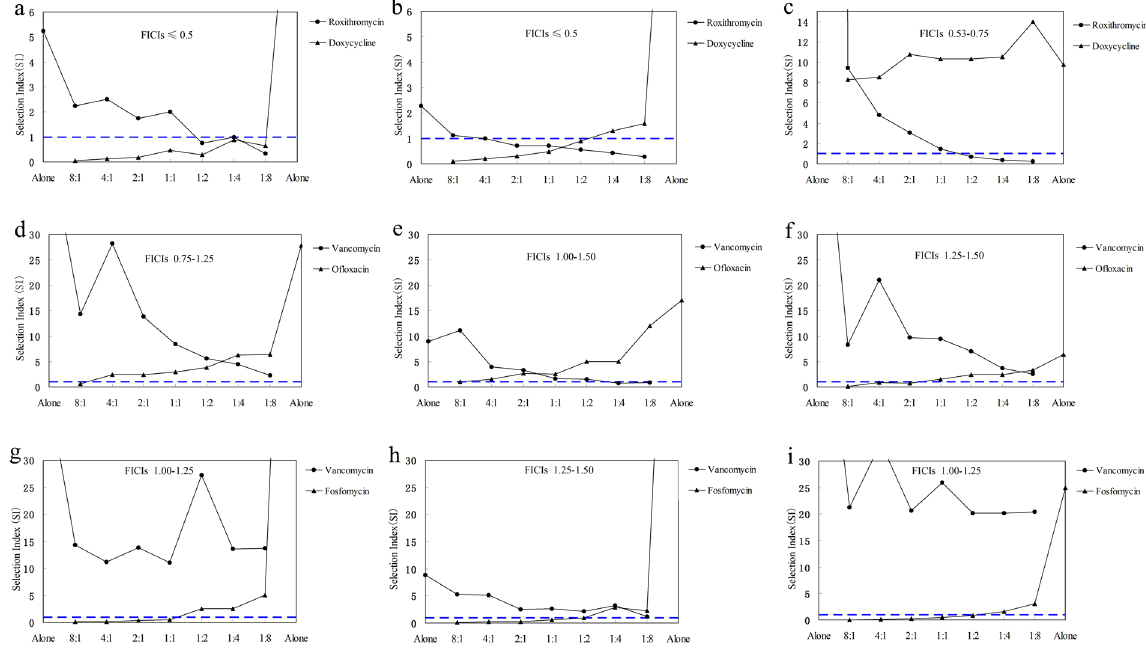
Figure 1. Mutant selection indexes (SIs) of antimicrobial agents in three combinations with different fractional inhibitory concentration indexes (FICIs) against three clinic MRSA isolates. ( a – c ), combination roxithromycin/ doxycycline against clinical isolates MRSA 01, 02 and 03; ( d – f ), combination vancomycin/ofloxacin against clinical isolates MRSA 01, 02 and 03; ( g – i ), combination vancomycin/fosfomycin against clinical isolates MRSA 01, 02 and 03. That the FICIs of combinations were less than or equal to 0.50 meant that two agents in combinations presented synergistic activities against a specific MRSA isolate. That the SIs of two agents in a combination including seven proportions were simultaneously less than or equal to one represented their MSWs were closed each other. ( a – f ) were published as an abstract of poster presentation at ISAAR&ICIC 2017 43